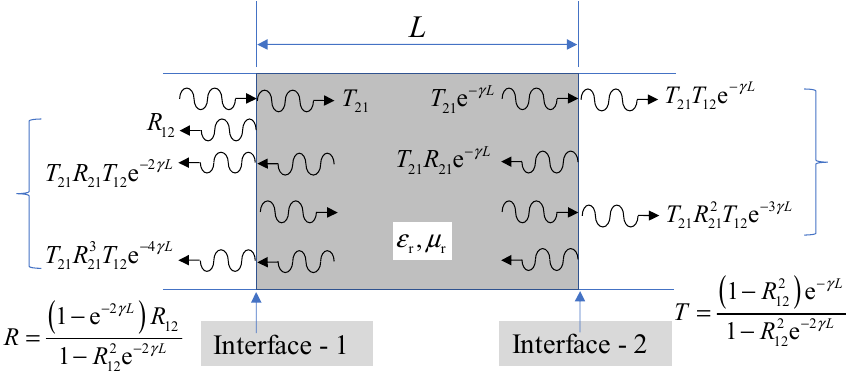
Figure 4. Multi-reflection model.